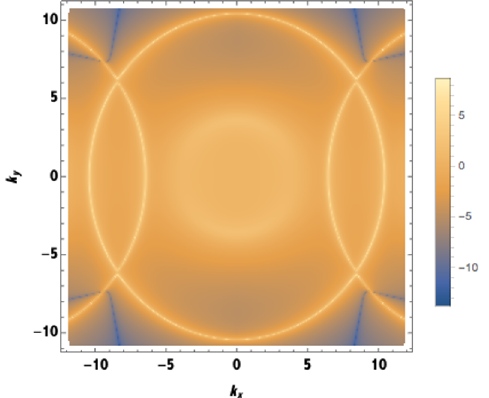
Figure 2. Density Plot of logarithm of the spectral function A over ( k x , k y ) -plane in absence of ionic lattice.